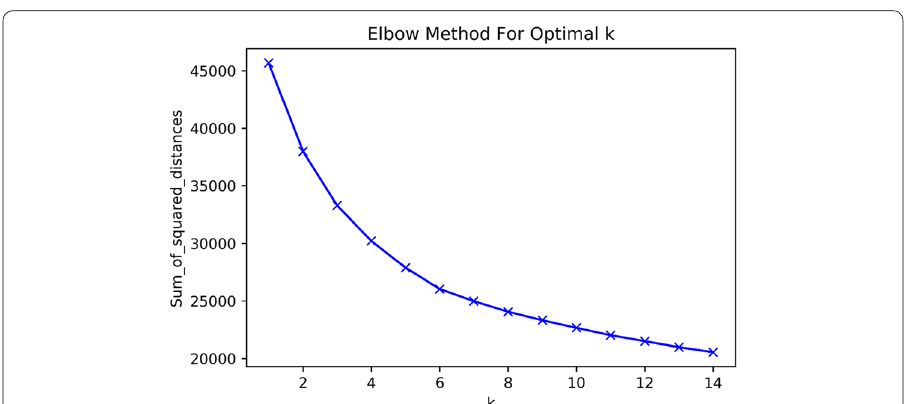
Fig. 7 Optimal number of clusters for Encoded